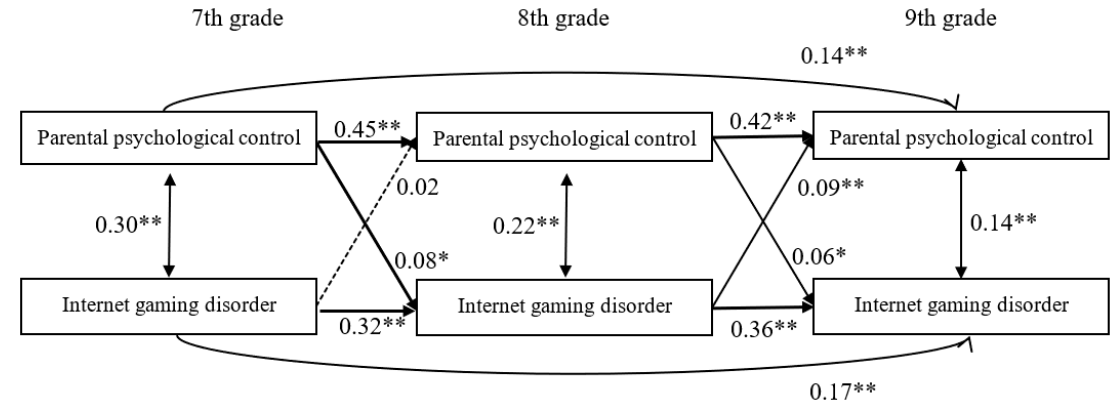
Figure 1. Model of the longitudinal association between parental psychological control and Internet gaming disorder. Note. The dotted line indicates a non-significant relationship. The path coefficients are standardized coefficients. * p < 0.05, ** p < 0.01.